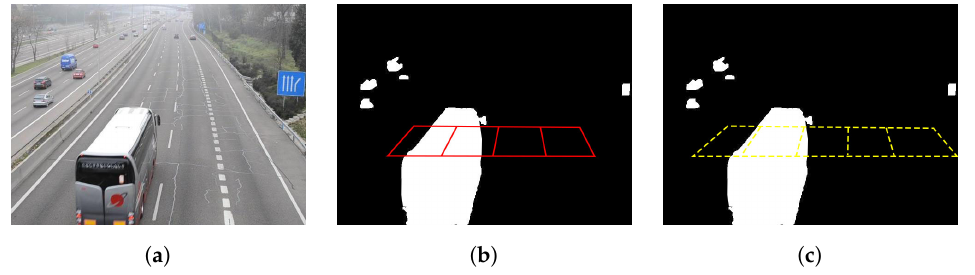
Figure 23. Example of redundant counting. ( a ) Example frame under RGB mode. ( b ) Detection result set with primary loops. ( c ) Detection result set with secondary